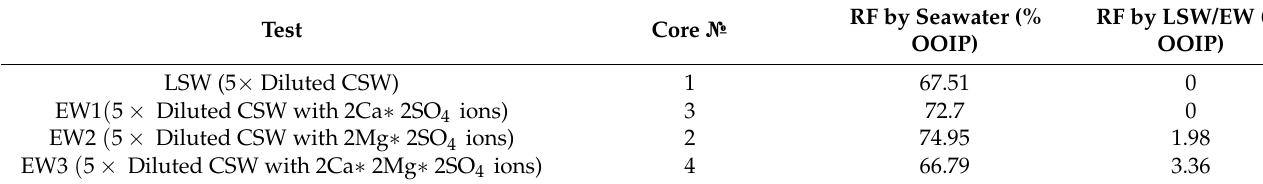
Table 5. Core flooding results summary.